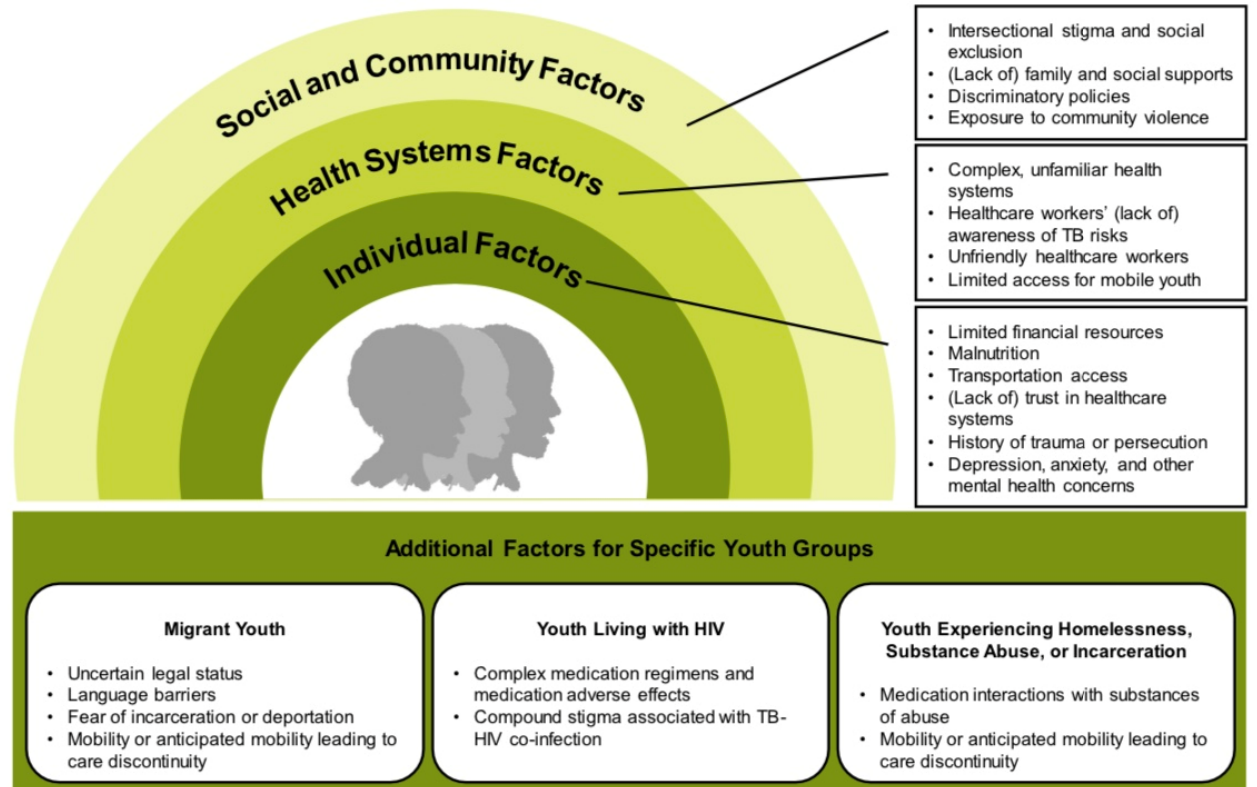
Figure 1. Barriers to TB Care for Marginalized Adolescents and Young Adults.